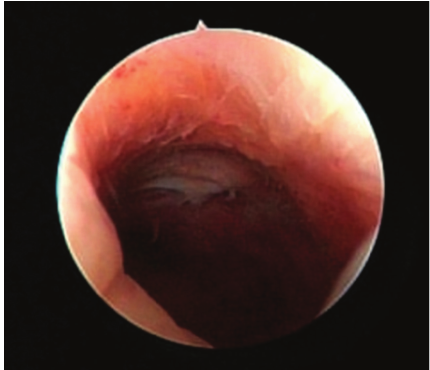
Figure 1: Intrauterine remnant of TachoSil (hemostatic fleece) vis- ualized by